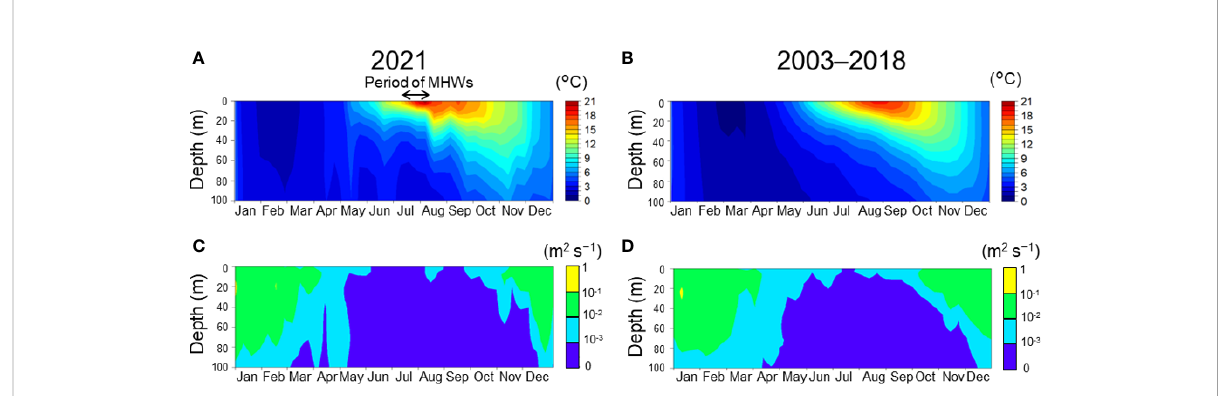
FIGURE 4 Seasonal changes of water temperature (A, B) and vertical diffusion coef fi cient (C, D) at Stn. A1. A and C indicate the daily mean in 2021. B and D indicate averaged daily means during 2003 – 2018. Black arrows indicate the period when the marine heatwaves occurred. Daily means were extracted from a three-dimensional realistic ocean model with a horizontal resolution of 1/50° (Kuroda et al., 2021).